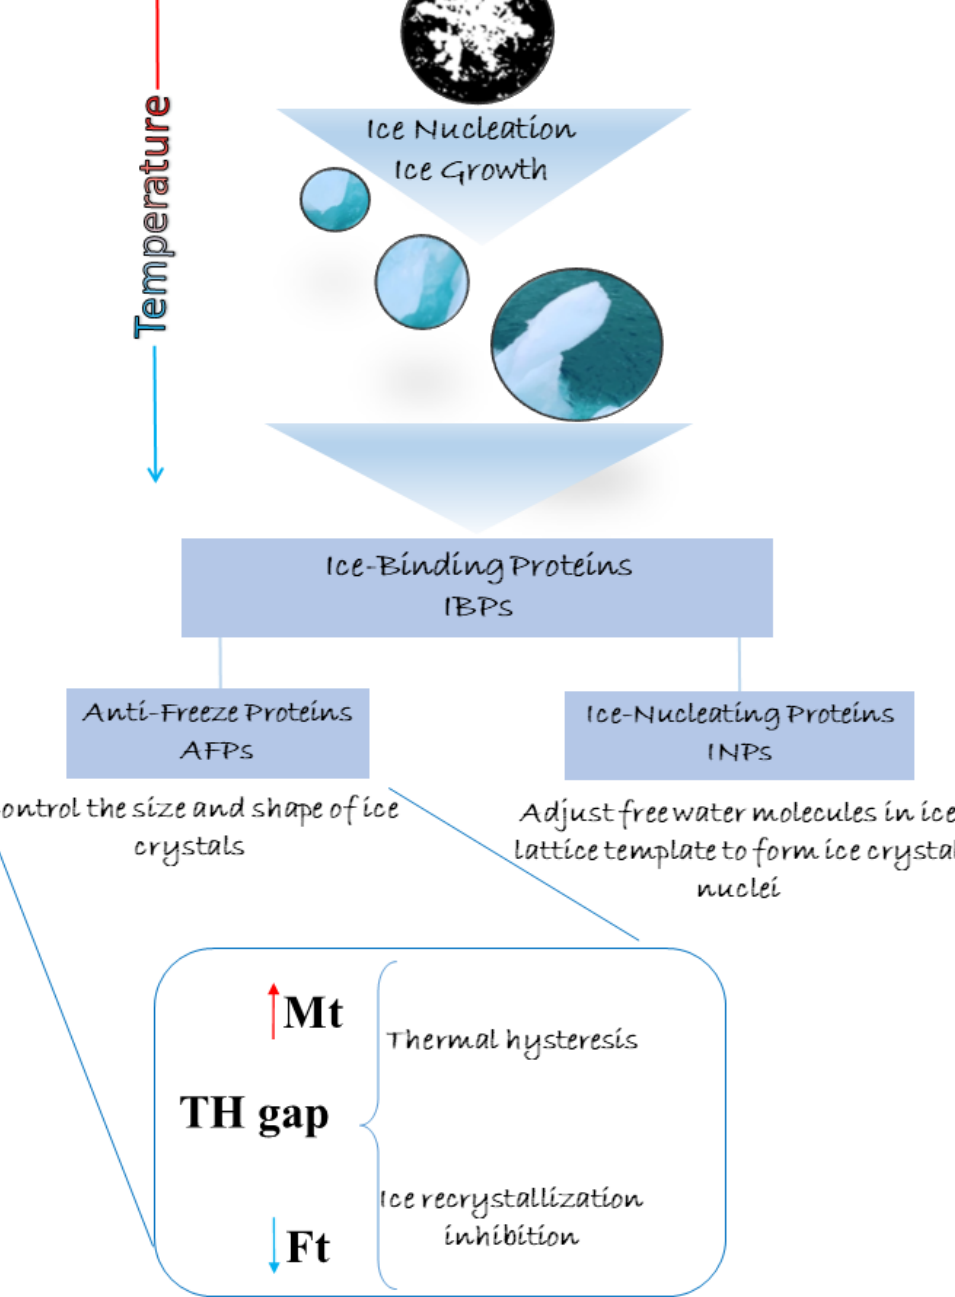
Figure 2. Schematization of ice binding proteins (IBPs) and their action toward ice formation. IBPs are distinguished in antifreeze proteins (AFPs), which prevent recrystallization processes, and ice- nucleating proteins (INPs), which regulate the ice formation in the extracellular space. AFPs act by increasing the melting temperature (Mt) and decreasing the freezing temperature (Ft). This triggers a thermal hysteresis (TH) gap and, if the external temperature falls within it, water in liquid and crystal forms enters a supercooled state (no melt nor frozen).